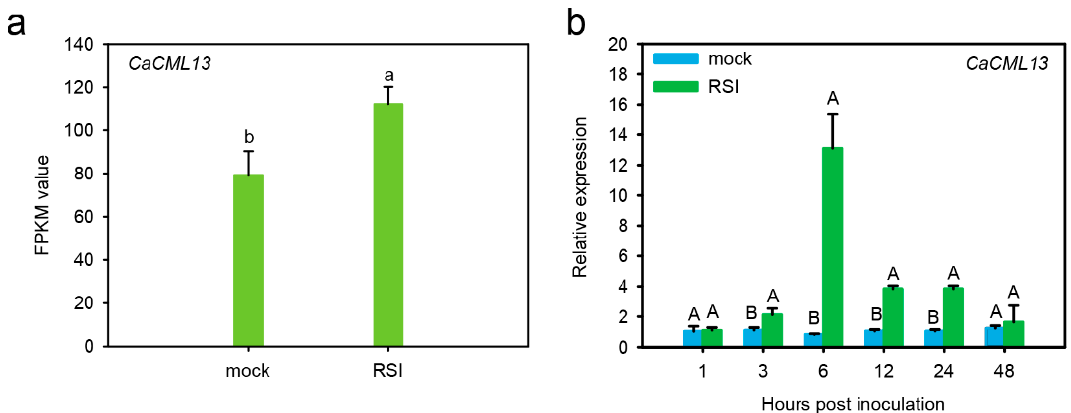
Figure 1. Transcriptional response of CaCML13 to RSI. ( a ) fragments per kilobase million (FPKM) of CaCML13 in pepper roots by RNA-seq. The RNA-seq data used in this study have been deposited at the China National GeneBank DataBase (CNP0001104); ( b ) relative transcript levels of CaCML13 in roots of pepper plants challenged with RSI by qRT-PCR. Data presented are means ± standard error of four replicates. Di ff erent uppercase letters above the bars indicate significant di ff erences among means ( p < 0.01) by Fisher’s protected least significant di ff erence (LSD) test. Di ff erent lowcase letters above the bars indicate significant di ff erences among means ( p < 0.05) by Fisher’s protected LSD test. 2.2. The CML Is CaCML13 Exhibiting High Sequence Similarities to CMLs in Other Plant Species The deduced amino acid sequence of the RSI upregulated pepper CML gene, encodes a 16 kDa protein with 444 bps, exhibited highest sequence similarities to CML13 among all of the CML members in di ff erent plant species including plants in the family Solanaceae, such as Solanum lycopersicum ( CML13 , XP_004234945.1) with 98% identity, Solanum tuberosum ( CML13 , XP_006340368.1) with 95% identity, Nicotiana tabacum ( CML13 , XP_016434602.1) with 92% identity and other plant species including Sesamum indicum ( CML13 , XP_011101132.1) with 91% identity, Ipomoea nil ( CML13 , XP_019192673.1) with 90% identity, Jatropha curcas ( CML13 , XP_012087102.1) with 89% identity, Citrus sinensis ( CML13 , XP_006477274.1) with 90% identity and Arabidopsis thaliana ( CML13 , NP_172695.1) with 86% identity (Figure 2a,b). Since it has the highest homology with AtCML13 in all CML gene family members of Arabidopsis thaliana , this gene was named CaCML13 (XP_016564798.1). Unlike CaMs that generally have four EF-hand motifs, they have only three EF-hand motifs. CaCML13 displays higher sequence similarities to its orthologs in Solanaceae than that to its orthologs in other plants including Arabidopsis thaliana (Figure